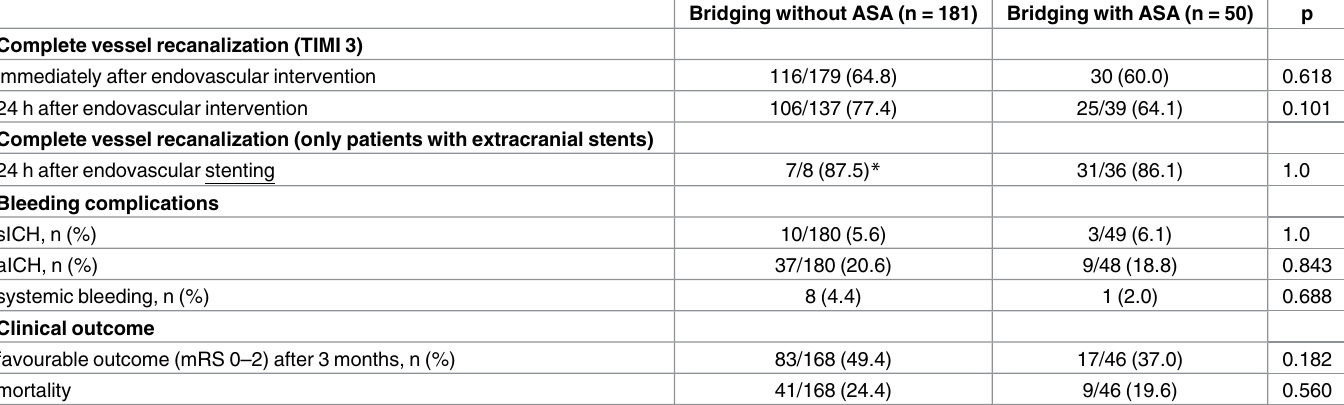
regression model, aspirin administration during endovascular procedure was not a predictor of sICH and aICH (p > 0.05). Diabetes (p < 0.038) and NIHSS score (p = 0.036) were indepen- dent predictors of sICH. We analyzed bleeding complications and outcome in antiplatelet naïve patients with those with previous or acute antiplatelet therapy (Table 4). Patients with previous antiplatelet